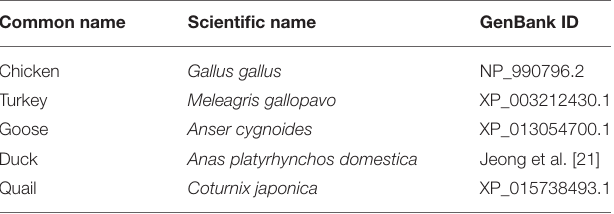
TABLE 1 | Detailed information on the avian sequences analyzed in this